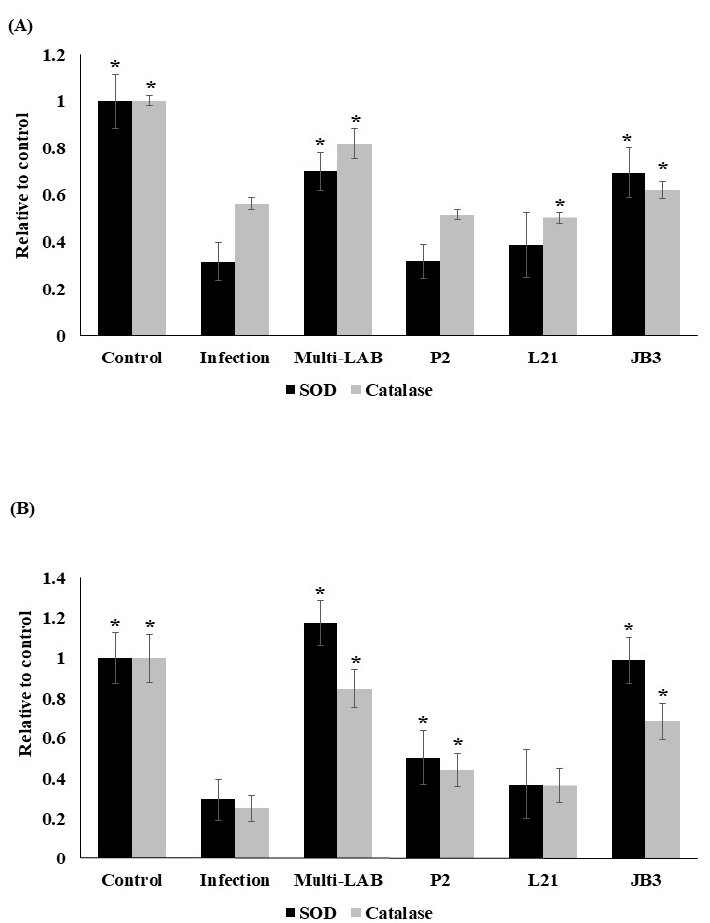
Figure 4. Effects of LAB strains on SOD and catalase activities in in serum ( A ) and stomach homogenates ( B ) of mice. * Means significantly different from infection group, p < 0.05. 3.5. Effects of LAB Treatments on H. pylori-Infection Mediated Serum Concentrations of Ammo Acids and Fatty Acids Infectious episodes create not only a set of symptoms, but also metabolic changes in individuals [19]. In this study, after one week of infection, the serum concentrations of certain amino acids and fatty acids were observed to have changed. However, LAB treatments modulated this change. The serum levels of 15 kinds of amino acids were suppressed by H. pylori infection as listed in Table 1. Multi-LAB increased the levels of alanine, arginine, aspartate, glycine, and tryptophan, which were all suppressed by infection. P2 affected the concentrations of alanine, arginine, aspartate, glycine,